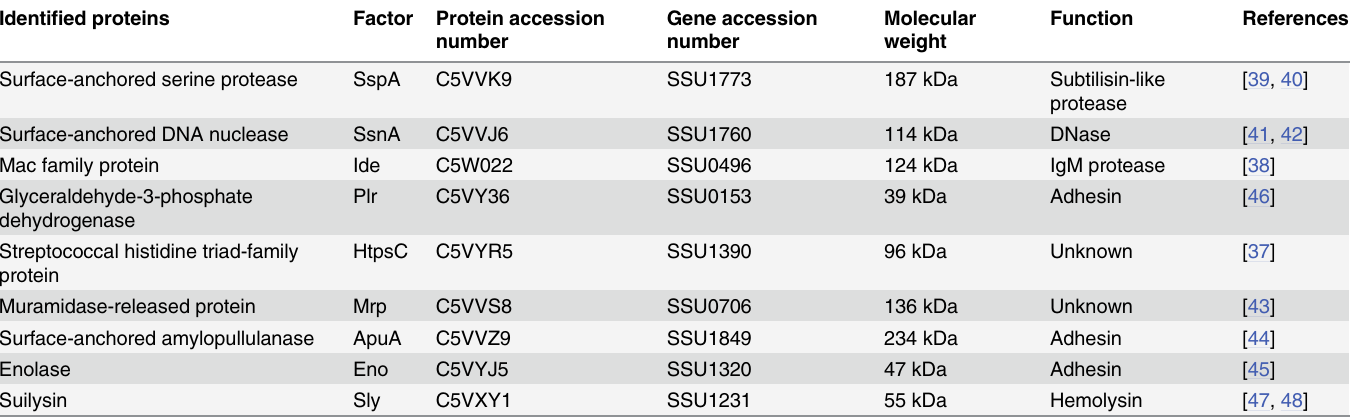
Table 2. Virulence factors identified in S . suis P1/7 membrane vesicles.